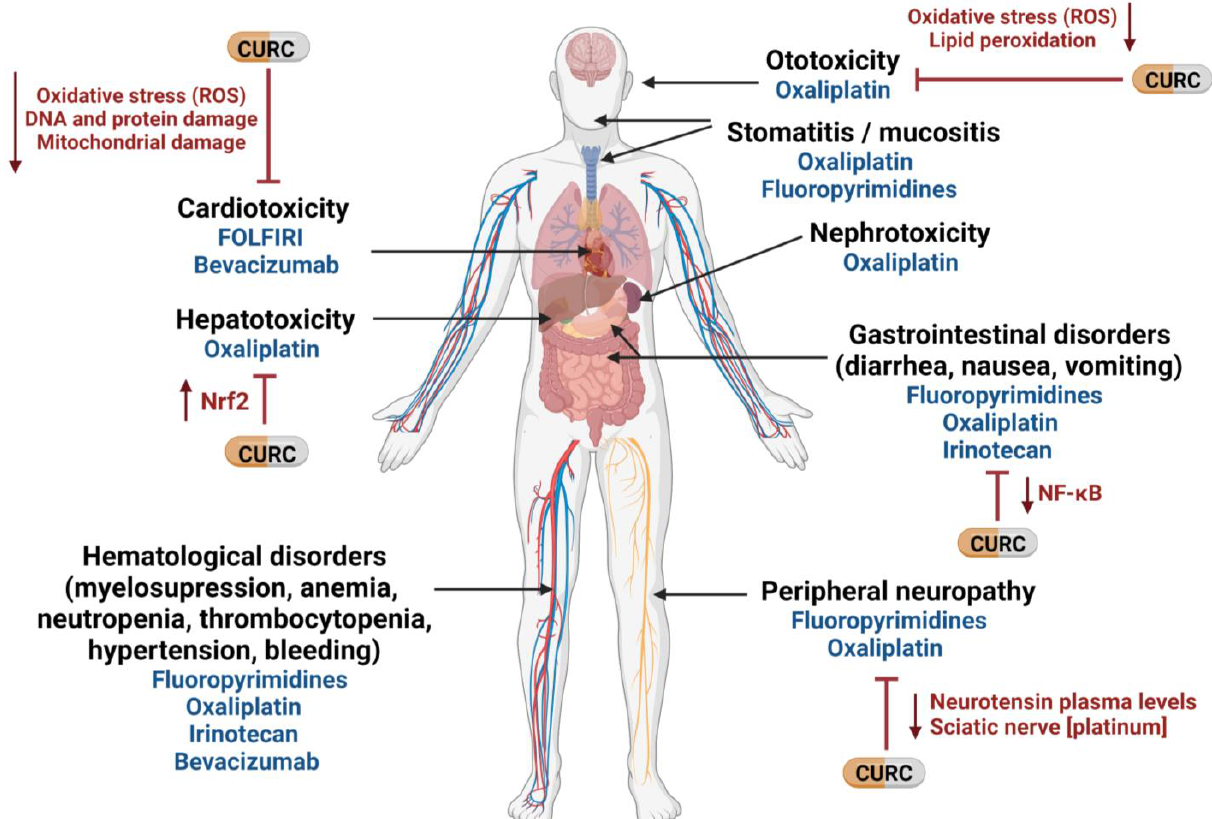
Figure 1. Potential use of curcumin to mitigate therapy-related side effects in mCRC. CURC: curcumin; NF- κB: nuclear factor kappa B; Nrf2: nuclear factor - erythroid 2 - related factor 2; ROS: reactive oxygen species. Created with BioRender.com. (accessed on 16th September 2022)